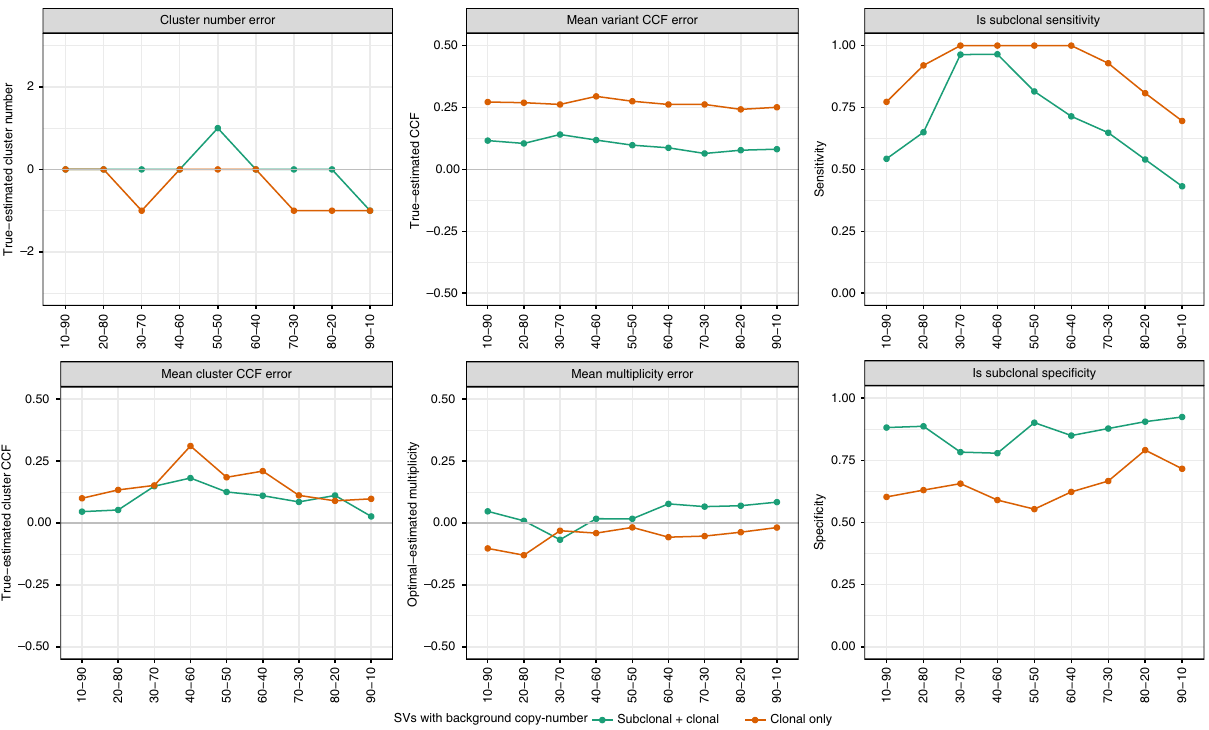
Fig. 5 SV clustering performance incorporating background subclonal copy-number states. Performance of SVclone run across the three-cluster in silico mixtures using either clonal background copy-number states, or clonal plus subclonal states. The fi rst column shows the cluster number error (three- inferred cluster number), and the mean CCF error, where true and inferred clusters are matched based on their order (see Methods). The second column shows the mean variant CCF and multiplicity error compared with the ground truth CCF. The third column shows the subclonal classi fi cation sensitivity and speci fi city using sample membership of the variant (i.e. a variant is classi fi ed as clonal if present in both samples of the mixture, and subclonal